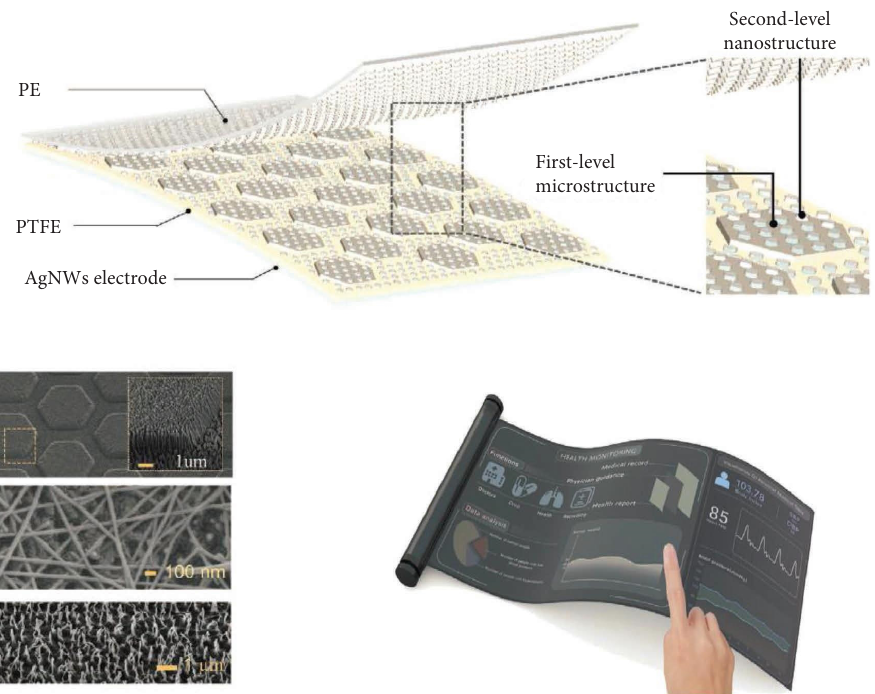
Figure 3: Te ultrathin and fexible sensor (UFS) shown in a simplifed schematic form, along with its single-electrode mode application for measuring when fngers are touched to a